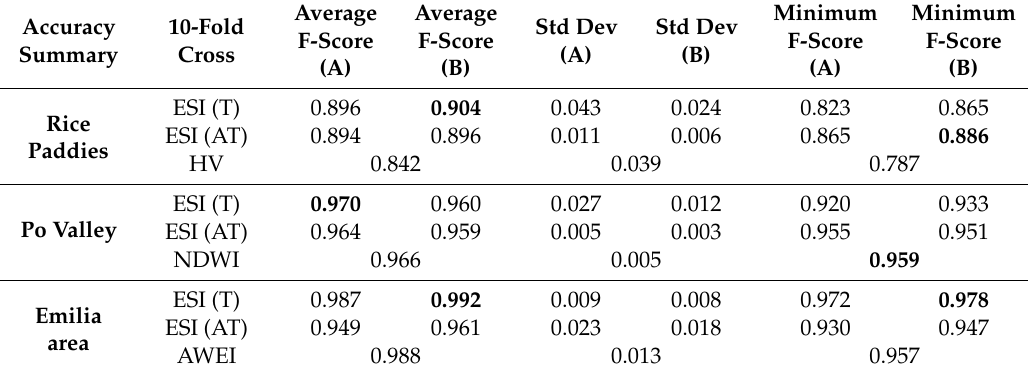
Table 5. Average, standard deviation and average minimum F-score values over all 10 runs of the algorithm and all thresholds in the typical (T) and atypical (AT) validations using soft constraints defined by expert A and B and based on the best-performing SI on the ROI. Best results are highlighted in